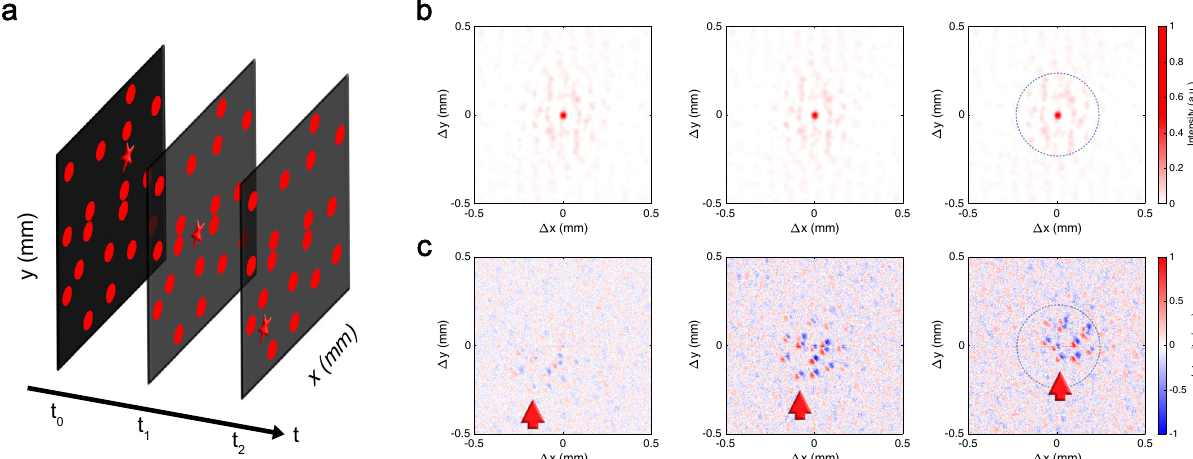
Fig. 3 | Experimental results of tracking a moving star object over many static dots via speckle correlations. a Three representative still frames of the moving sceneontheDMD,madeofalargenumberofstaticdots,andasinglemovingstar. b The cross-correlation between the measured speckle patterns at t 0 and the speckle patterns at successive times. The cross-correlation decreases with distance from the centre due to the fi nite memory effect range. c Plot of I ( t n ) ⋆ − I ( t n ) ⋆ I ( t n ), where I ( t n ) is the measured speckle pattern at frame n (see I ( t n − 2 )